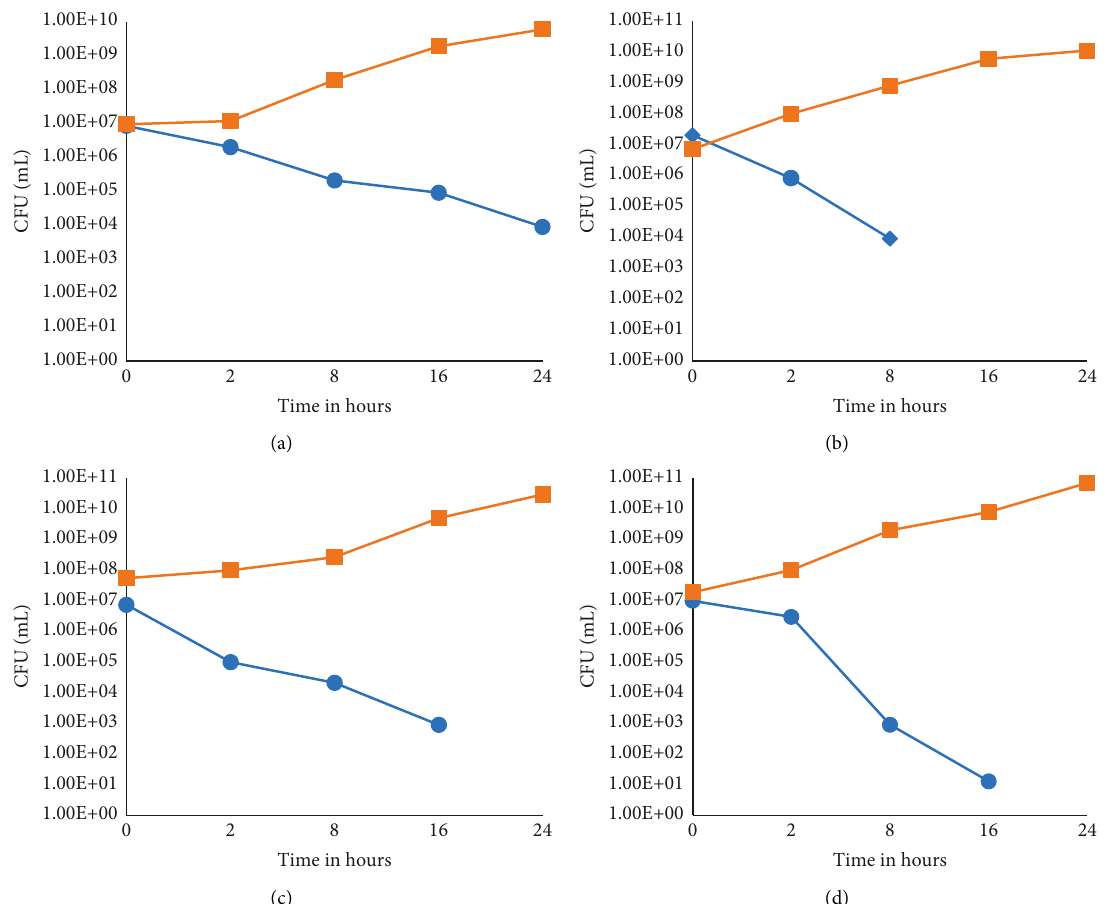
Figure 3: Kill time assay of Klebsiella pneumonia (a), Salmonella typhi (b), Staphylococcus aureus (c), and Escherichia coli (d) in the presence of propolis oil. Black circle ( ● ) represents the test bacterial growth, and black square ( ■ ) represents the control bacteria